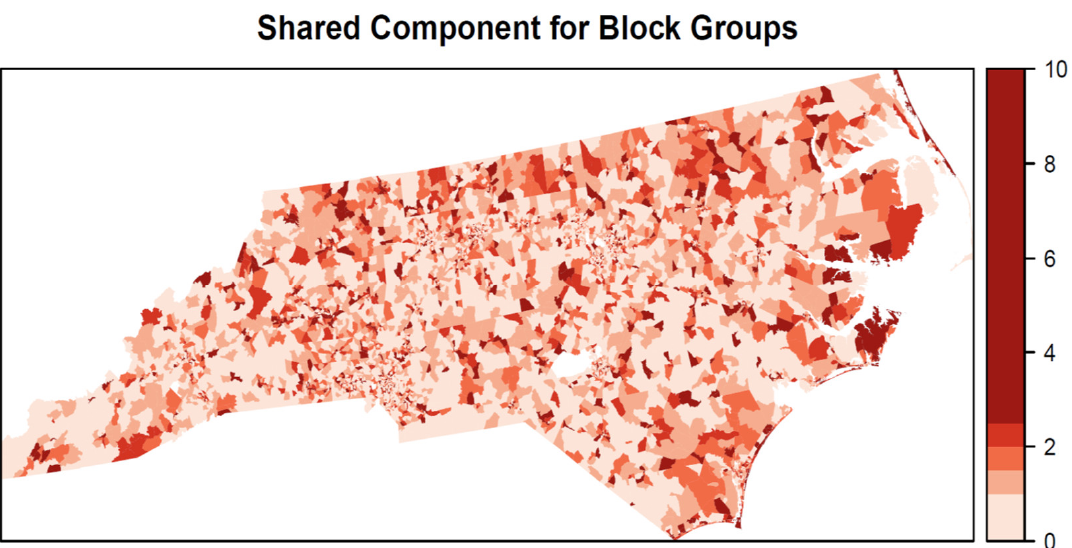
Figure 6. Shared risk component among the three outlet types (TRO, ARO, and TARO).